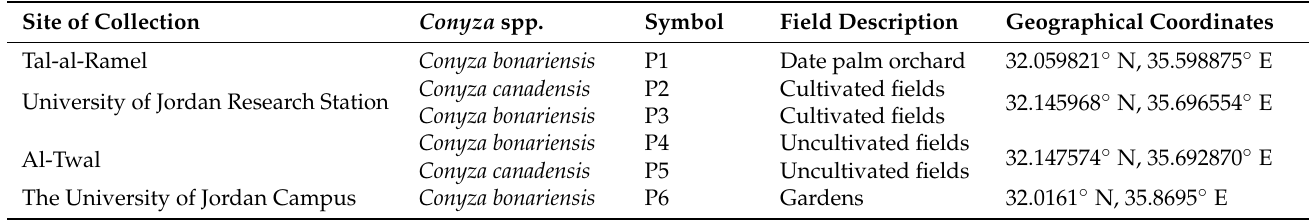
Table 1. The collected populations of Conyza spp. and their geographical